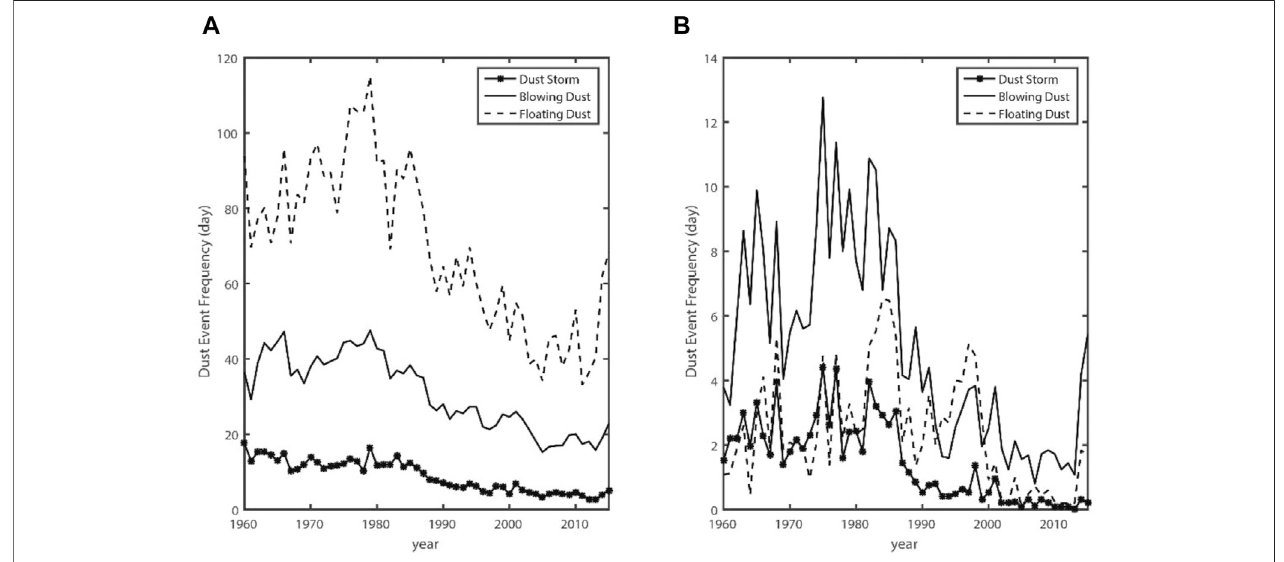
FIGURE 5 | Interannual Variations of dust storm, blowing dust and fl oating dust in (A) Southern Xinjiang and (B) Northern Xinjiang.